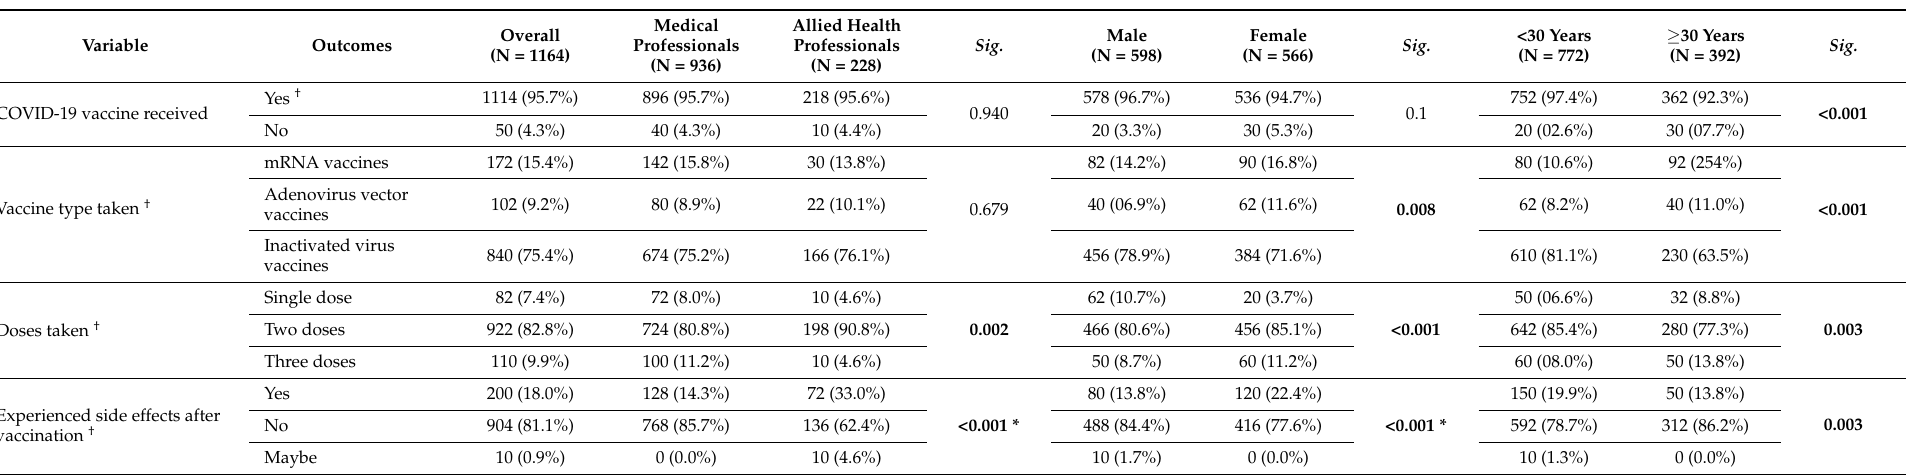
Table 3. COVID-19 vaccine-related details of the